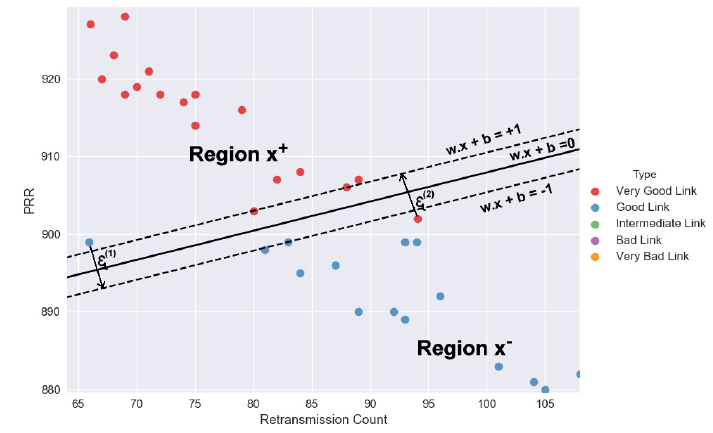
Figure 4. KLSVM: Linearly non-separable data points between the Very Good Link and the Good Link regions. The retransmission count patterns of these data points are inconsistent with the other data points of their